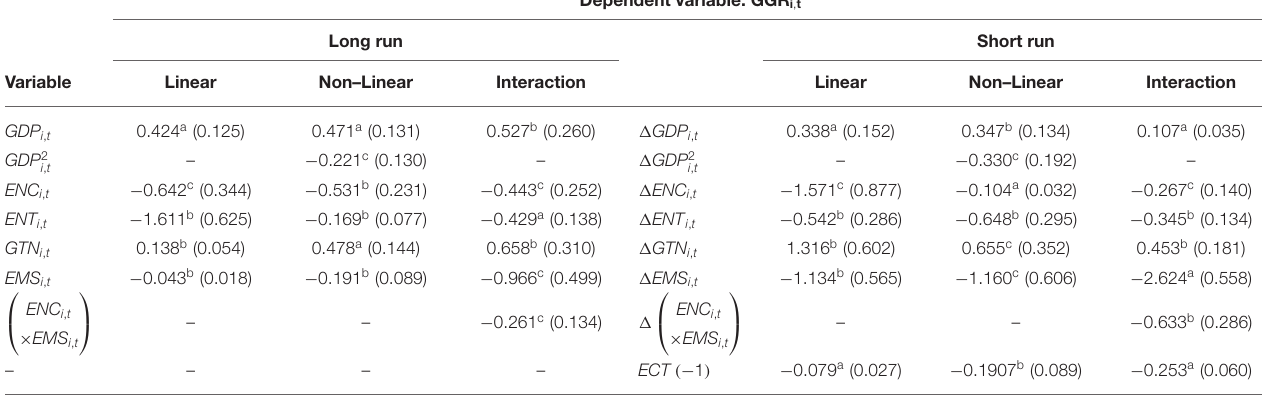
TABLE 8 | CS–ARDL estimations.